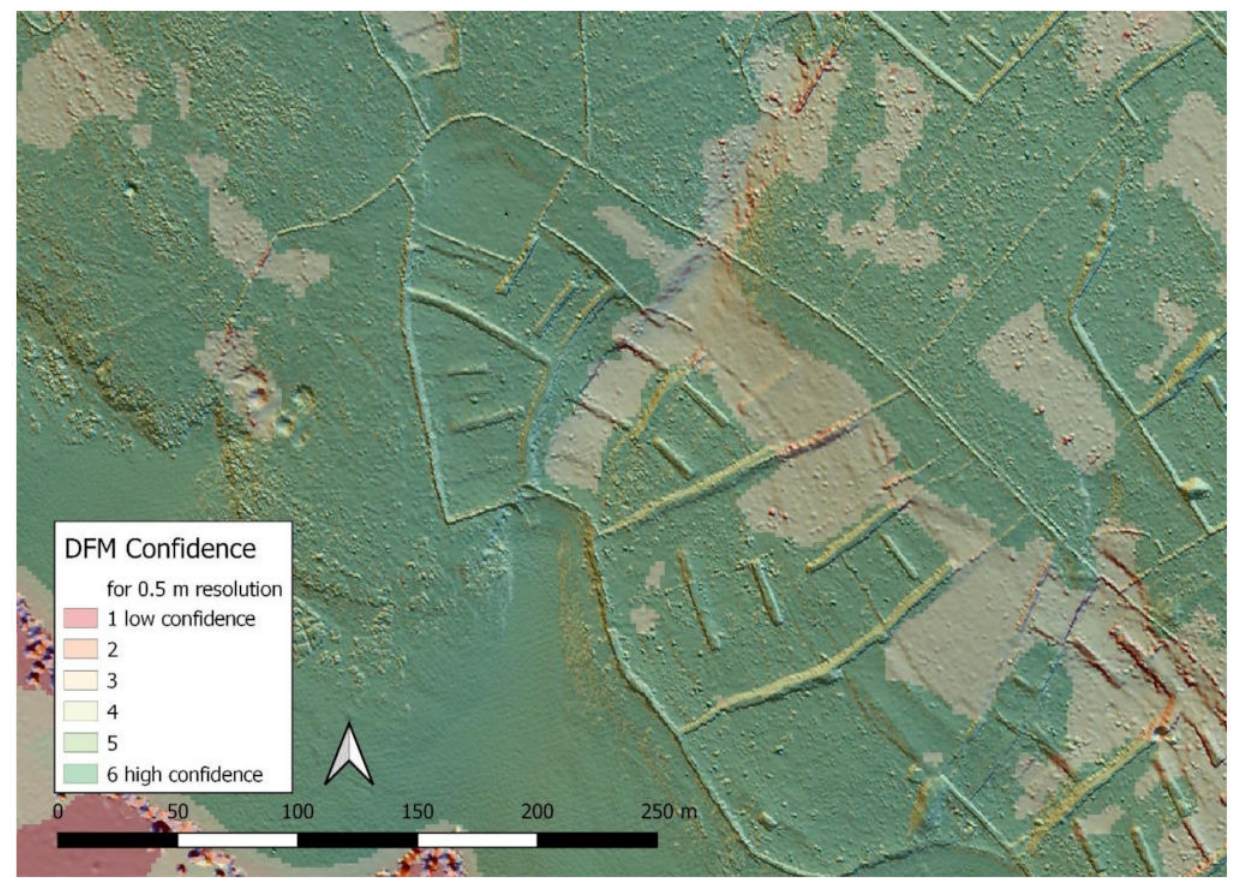
Figure 7. DFM confidence map showing the suitability of the ground point distribution for a DFM grid size of 0.5 m after classification using the “stone_wall” setting. Almost the entire area shows classes ranging from 4 to 6, which is adequate for interpolation using a 0.5 m